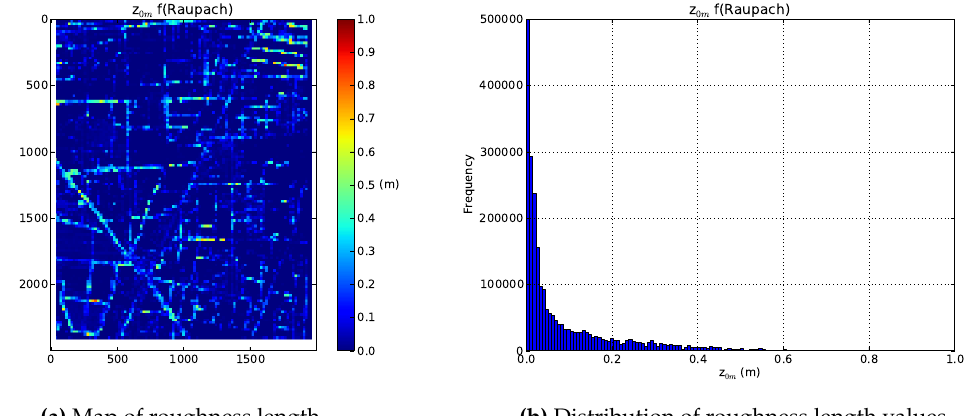
Figure 6. ( a ) Map and ( b ) frequency distribution of roughness length for momentum transfer values over the Yingke oasis station retrieved from CFD model.